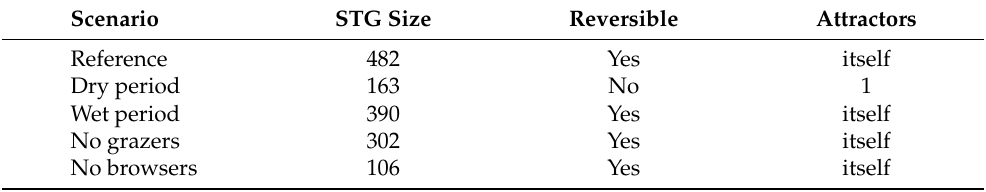
Table A3. General properties each scenario’s STG. STG size: Number of states; reversibility: Each